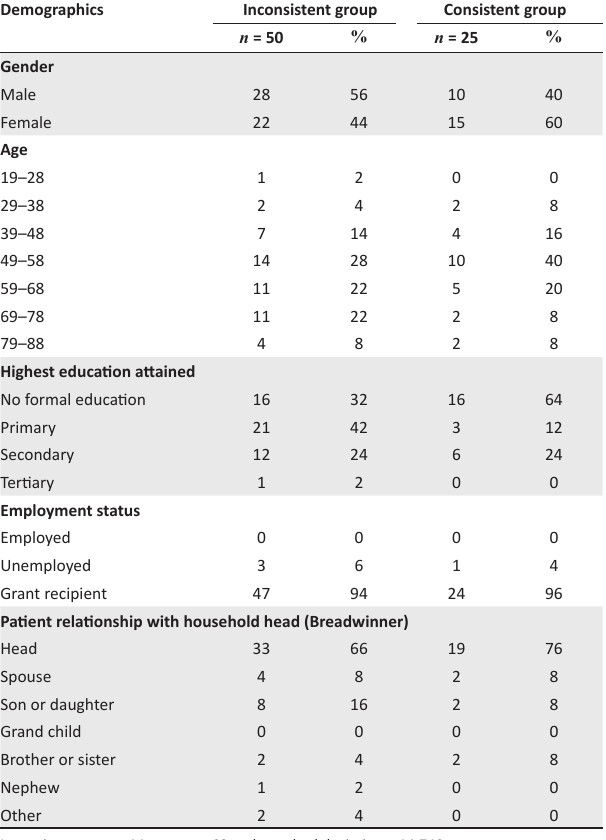
TABLE 1: Socio-demographic profile of inconsistent ( n = 50) and consistent ( n = 25) physiotherapy users. Demographics